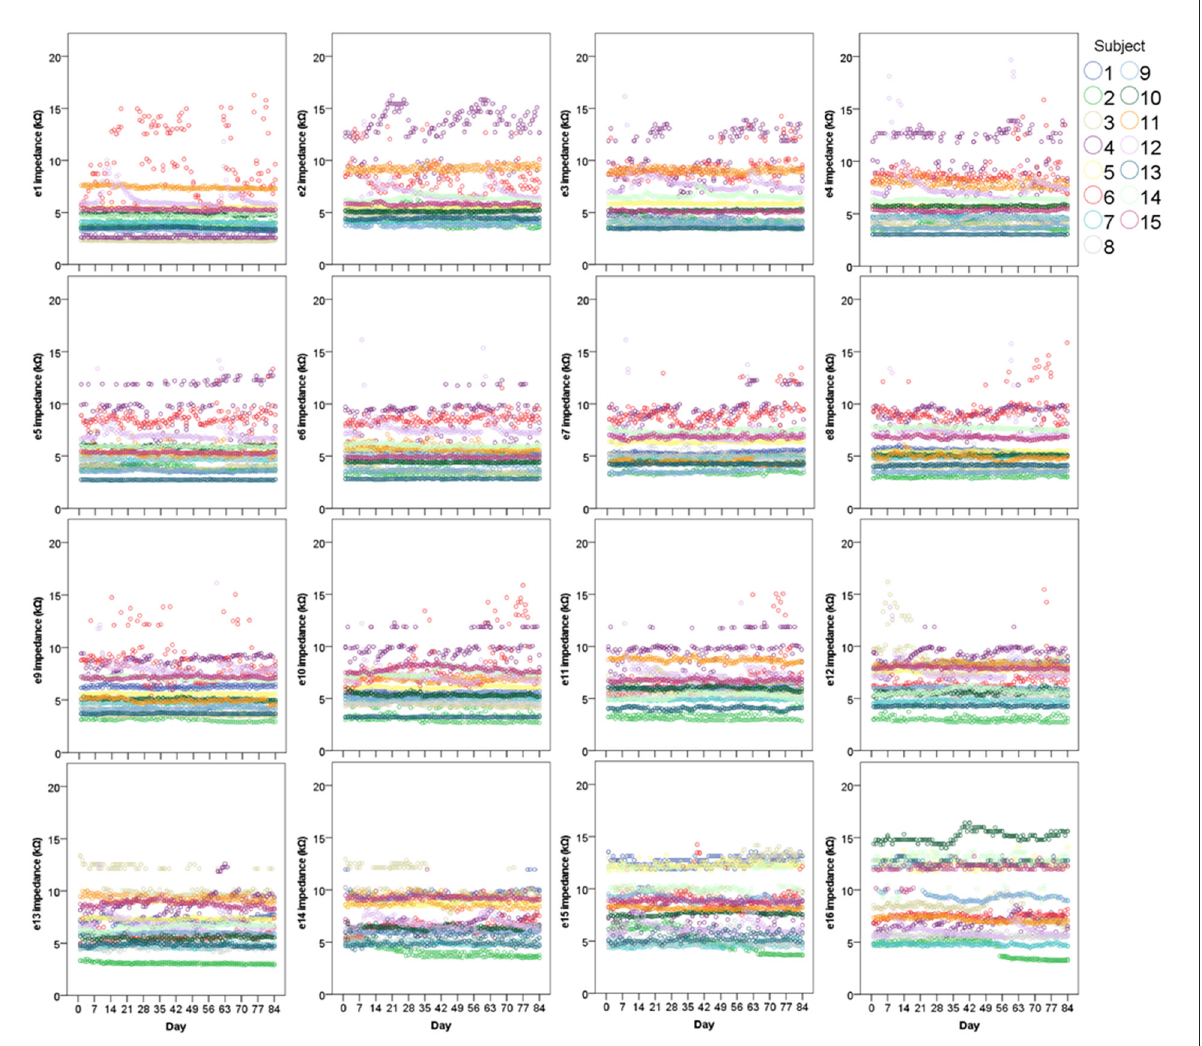
FIGURE2 Scatter graphs displaying individual electrode impedances at all 16 electrodes over 12 weeks ( N = 15). Two points (both AM and PM) are plotted for each